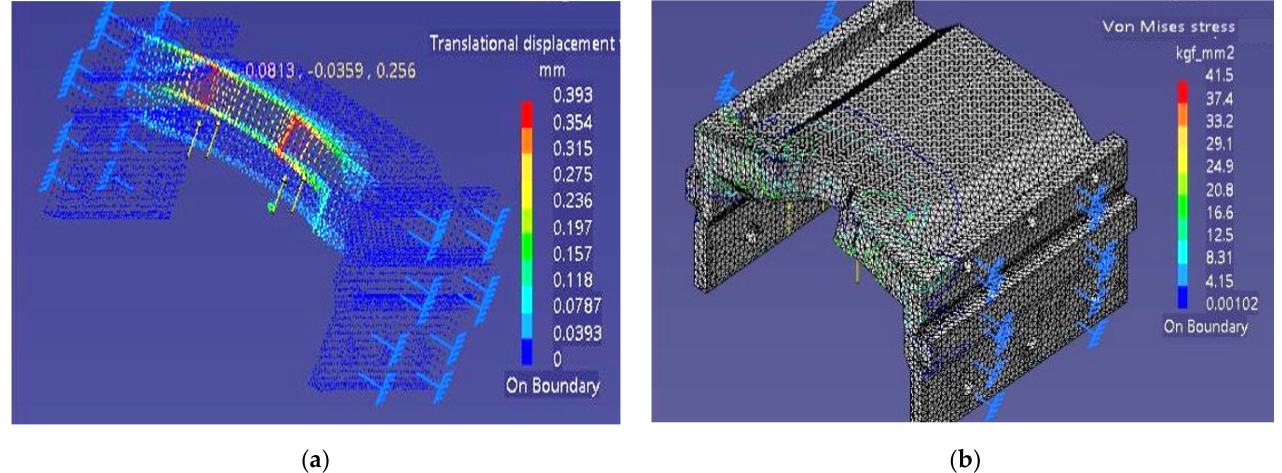
Figure 10. Deformation values ( a ) and of the equivalent stresses ( b ).